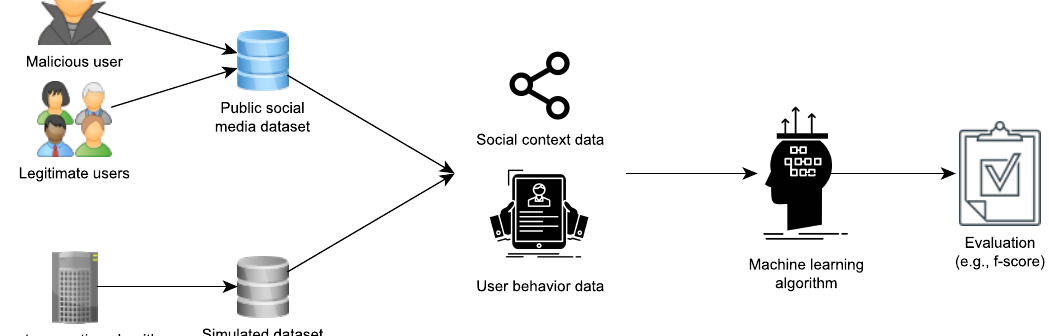
Figure 1. Typical identity deception detection experimental workflow. Data are selected from public sources or are simulated. Features are selected based on social and/or user behavior data. A model is constructed based on a machine learning algorithm, and it is further evaluated using metrics such as the